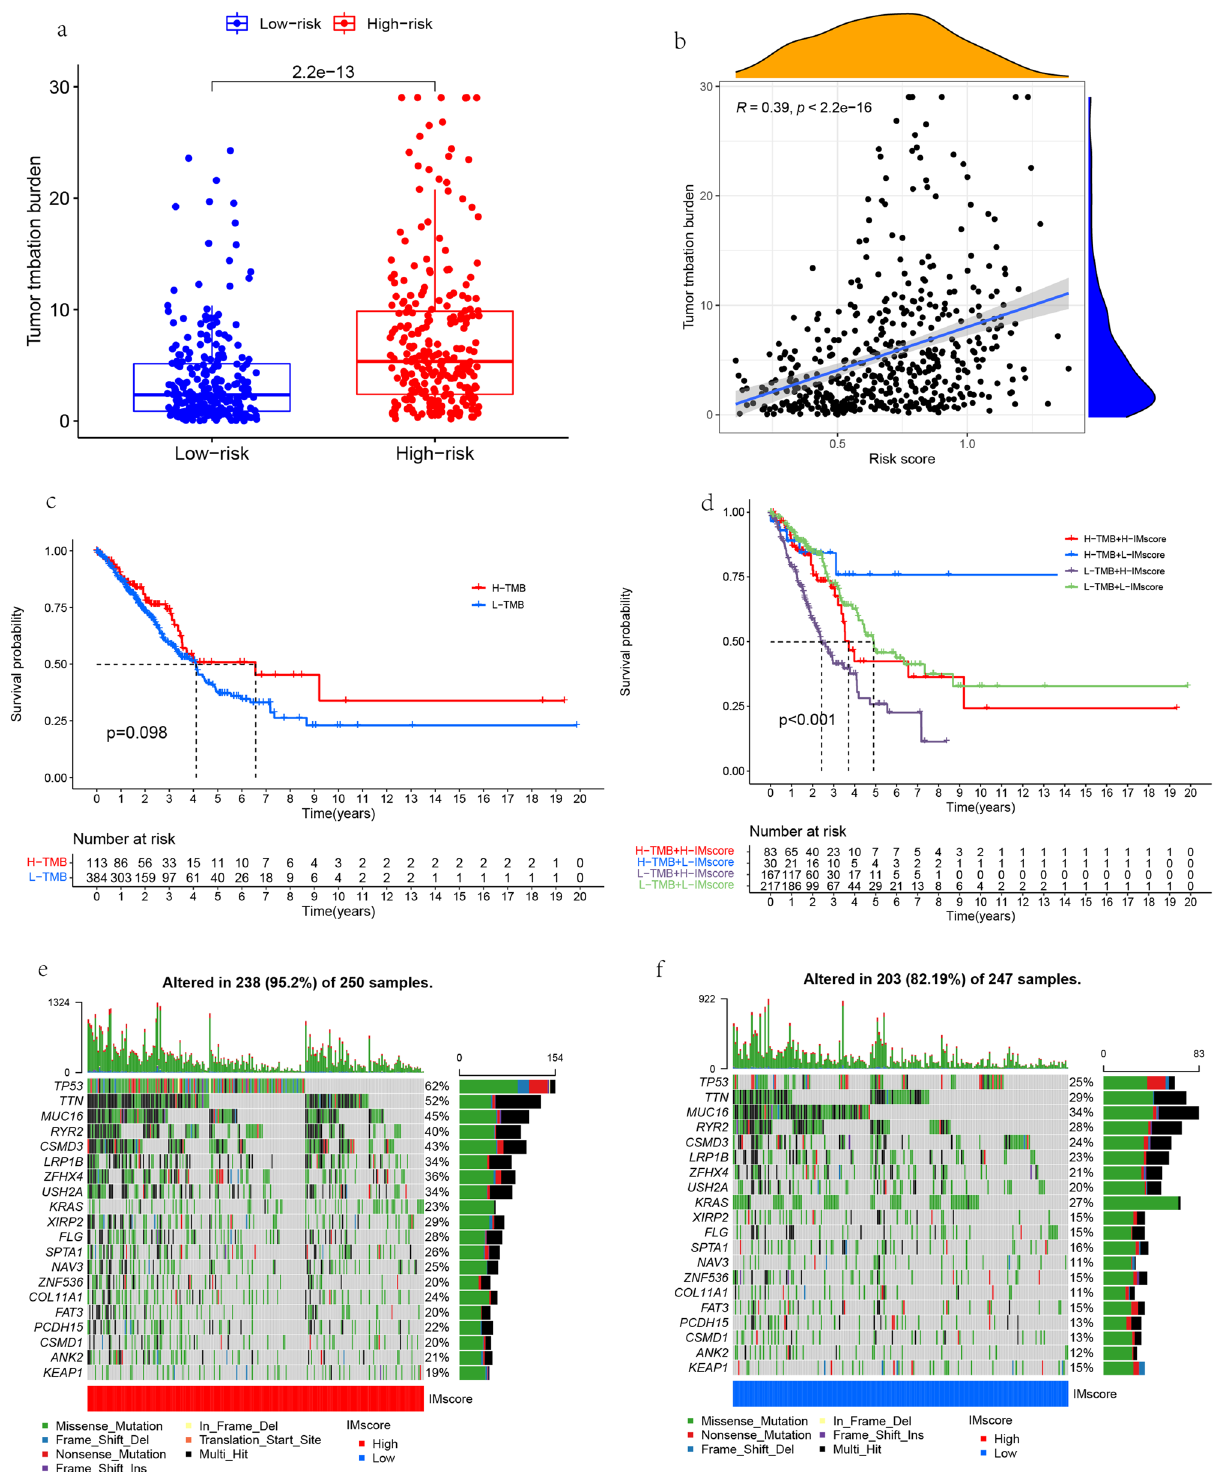
Figure 9. TMB between high and low risk groups. ( a ) Differences in Tumor Mutational Burden (TMB) between high and low risk score groups in the The Cancer Genome Atlas (TCGA) cohort. ( b ) Association between risk score and TMB in TCGA queue. ( c ) Kaplan Meier OS curve of high and low TMB groups. ( d ) Kaplan Meier OS curve of IMscore and TMB. ( e ) High TMB group in TCGA queue. ( f ) Low TMB group in TCGA